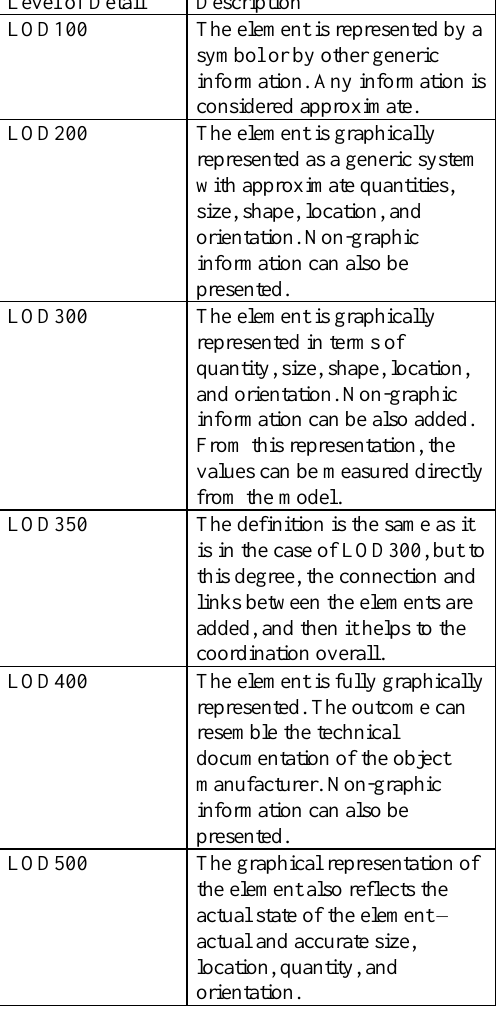
Table 1 . Description of the Level of